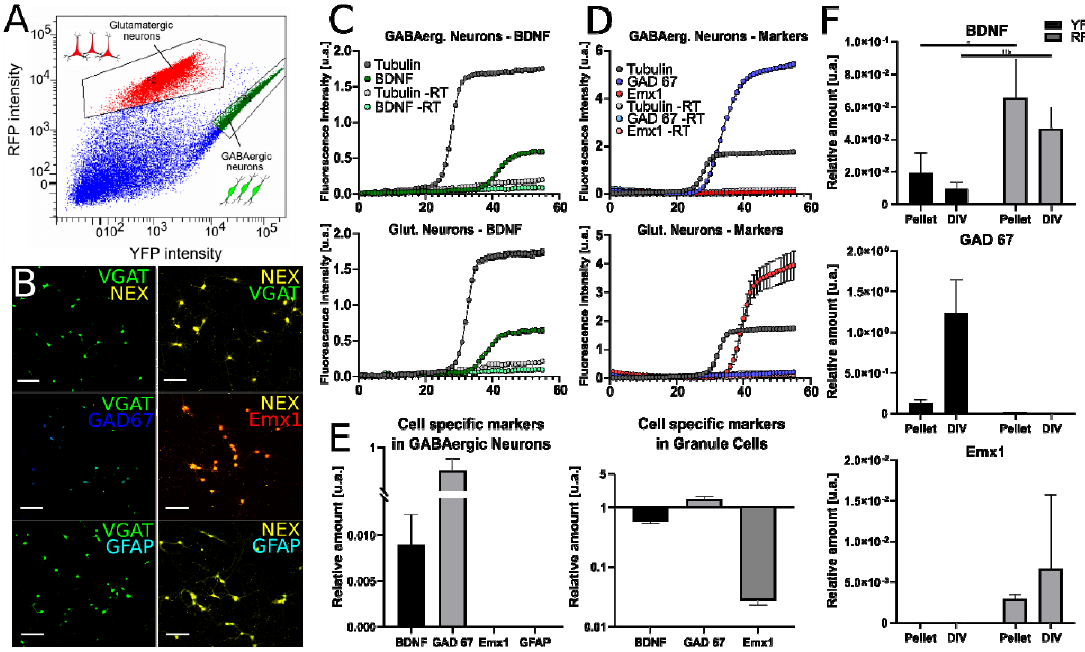
glutamatergic fraction (Table 4). The purity of sorted and cultured GABAergic samples was confirmed by the lack of Emx1 gene expression in all, but a single GABAergic sample at a very low level (delta-Cp = 0.00006; Table 4).